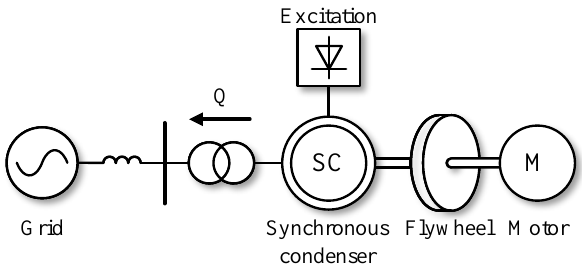
Figure 2. Diagram of a high-inertia synchronous